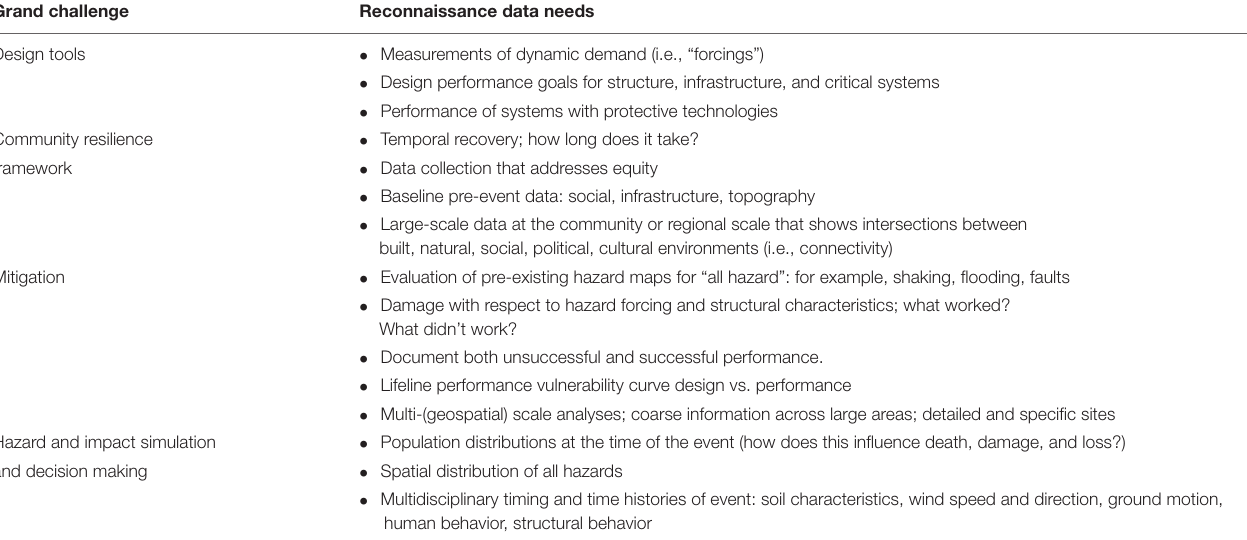
TABLE 3 | Synthesis of High Priority Reconnaissance Data Needs to address Grand Challenges for the natural hazards and disaster research communities (see Supplementary Material for complete